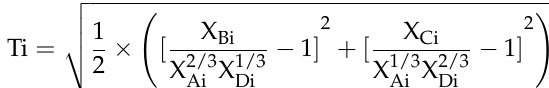
Figure 8. Classification plot of discriminant functions F1 and F2 for the Songhua River sediments. Provenance fields are from Roser and Korsch [36].